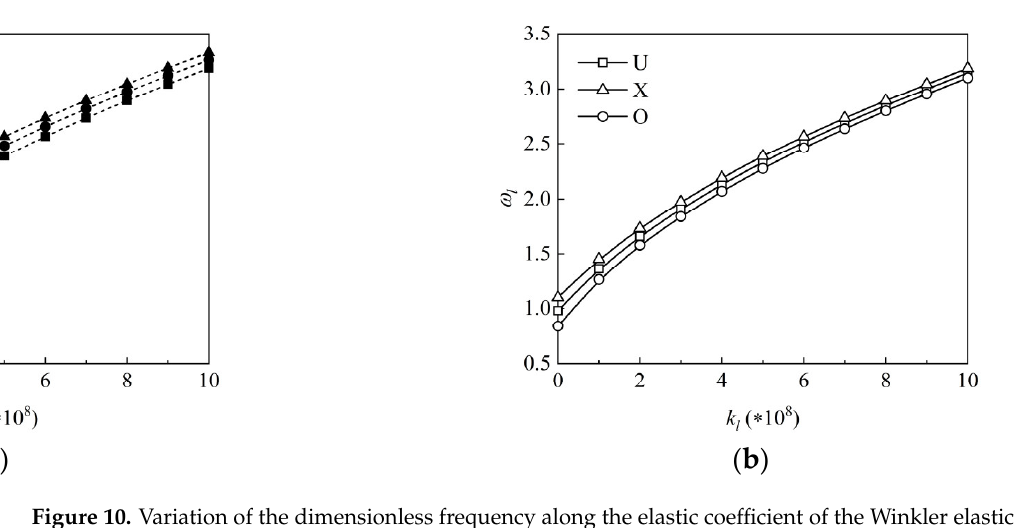
Figure 10. Variation of the dimensionless frequency along the elastic coefficient of the Winkler elastic foundation for an SSSS G-GRP plate under different ( a ) graphene volume fractions and ( b ) graphene distribution patterns.